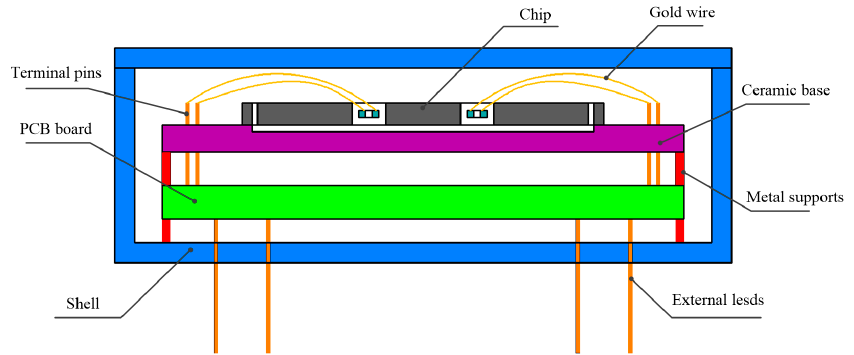
Figure 15. The schematic of the packaging sensor.